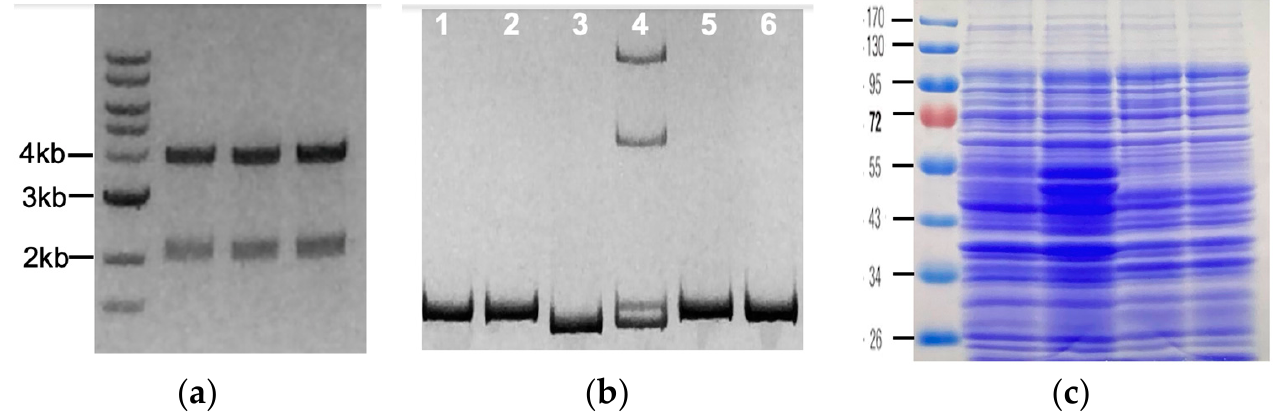
Figure 4. Examples of images obtained using our gel documentation apparatus and the autofocus feature of the iPad. The brightness of the images was adjusted for cosmetic reasons and the images were cropped; otherwise; no other image manipulations were performed. ( a ) Restriction digests of 3 plasmids were loaded on a 1% agarose/TAE gel next to molecular weight marker, with the MW of 3 bands indicated. ( b ) Low molecular weight PCR products from genotyping experiments were re- solved on a 15% polyacrylamide/TBE gel. The DNA in lanes 1 and 2 is 9 base pairs longer than the DNA in lane 3; Samples 1, 2, 5 and 6 contained wild type DNA; sample 3 was obtained from a homozygous mutant; sample 4 is heterozygous. ( c ) Homogenized yeast samples were separated on a 12% polyacrylamide/SDS gel and Coomassie- stained for protein. Samples in ( a , b ) were run in the presence of ethidium bromide and photographed using a UV light box; the gel in ( c ) was pho- tographed on a regular light box.